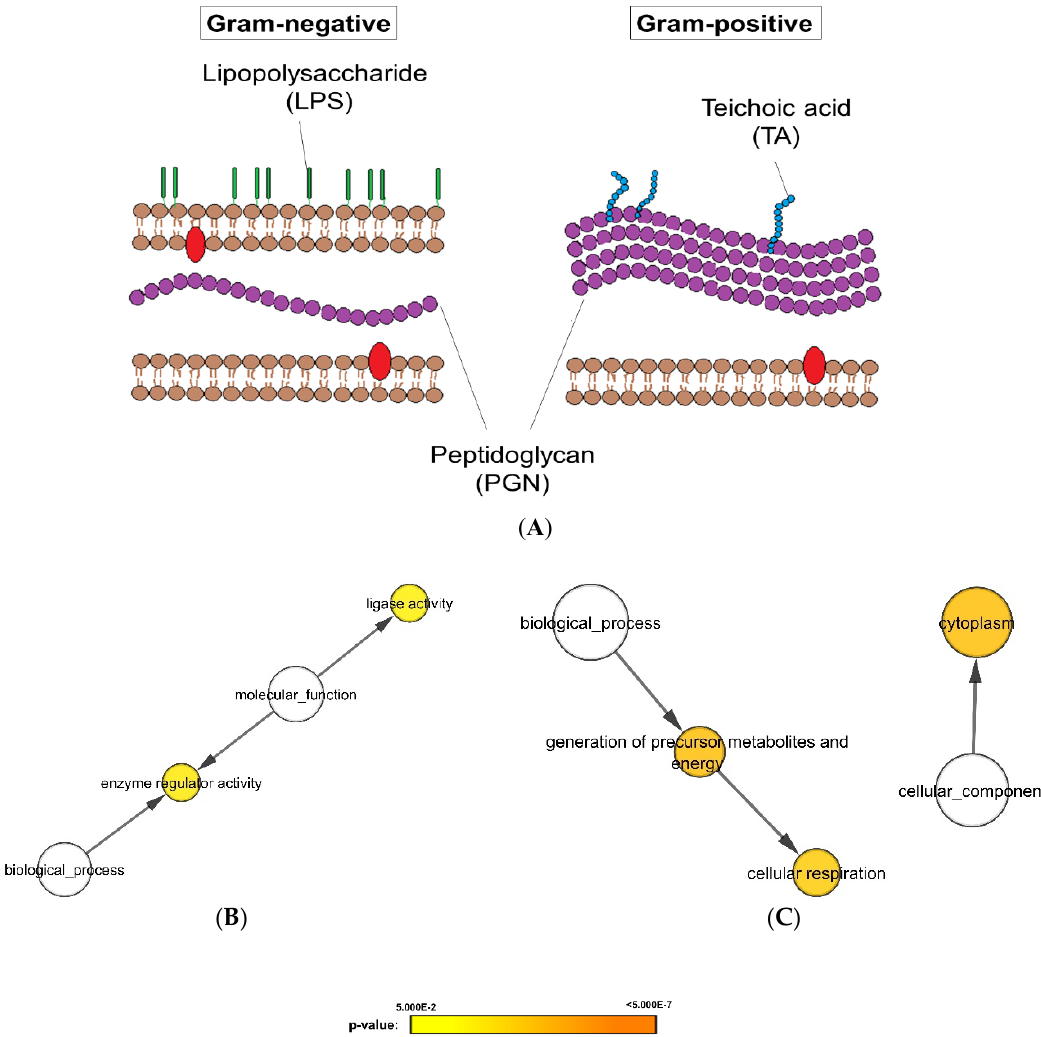
Figure 3. Differential expression and gene ontology analyses of proteomes of C. albicans biofilms when exposed to Gram-negative and Gram-positive heat-killed bacteria. ( A ) Schematic illustration of differences in cell wall components between Gram-negative and Gram-positive bacteria. Biological processes, molecular functions, and cellular components that are significantly lower in Candida biofilm exposed to ( B ) Gram-negative bacteria or ( C ) Gram-positive bacteria ( p -value < 0.05). The protein expression levels were represented in p -value using different colors: yellow (least significant) to orange (most significant). The white circles describe the 3 distinct aspects of how gene functions can be described: molecular function, cellular component, and biological process.